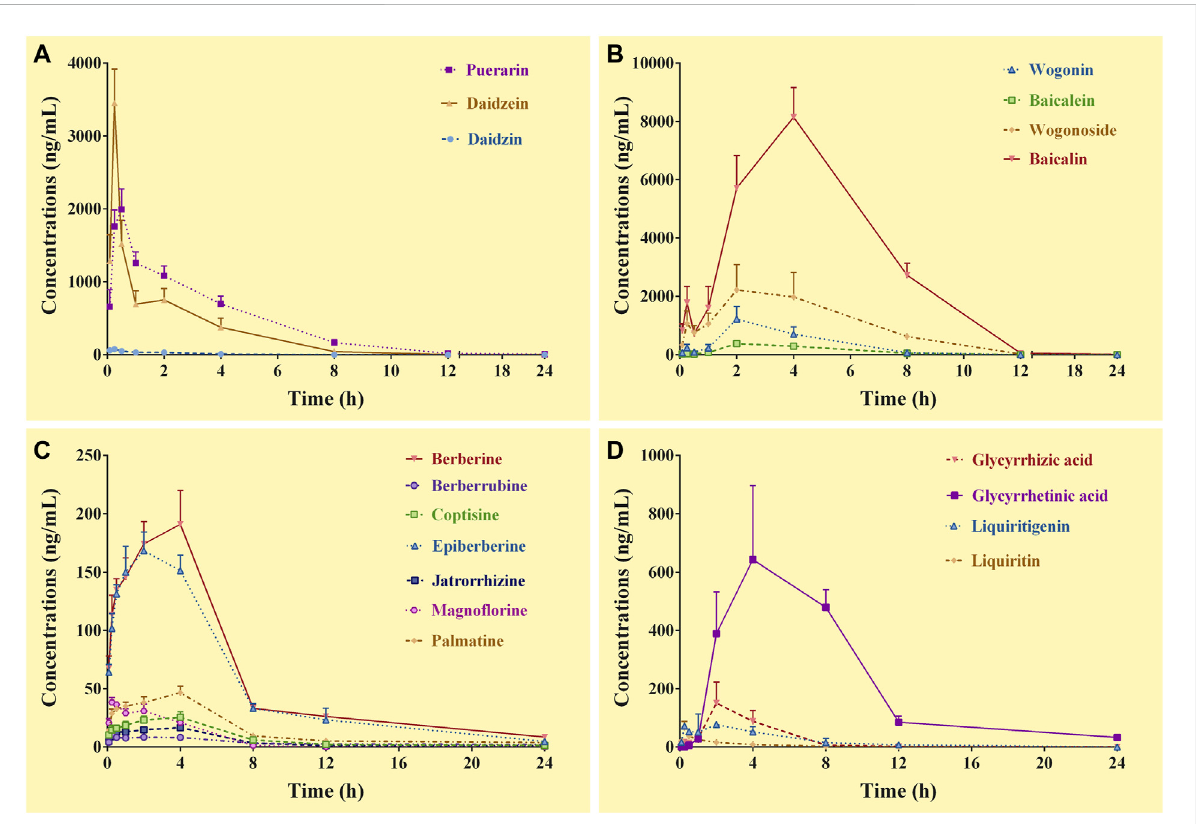
FIGURE 1 Concentration-time curves of the constituents of Gegen - Qinlian decoction in the portal vein of the mice received the oral Gegen - Qinlian decoctionatthedosageof6.1 g/kg(mean±SD,n=6). (A) ,constituentsderivedfrom PuerariaeLobataeRadix ; (B) ,constituentsderivedfrom Scutellariae Radix ; (C) , constituents derived from Coptidis Rhizoma ; (D) , constituents derived from Glycyrrhizae Radix Et Rhizoma Praeparata Cum Melle